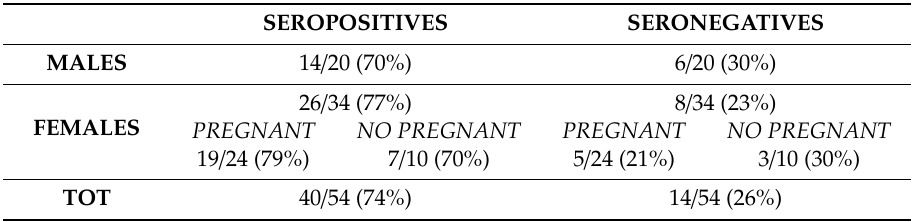
Table 1. Enzyme-linked immunosorbent assay (ELISA) serological results and seroprevalences percentage of sampled wild boar grouped by sex and pregnancy / no pregnancy status.